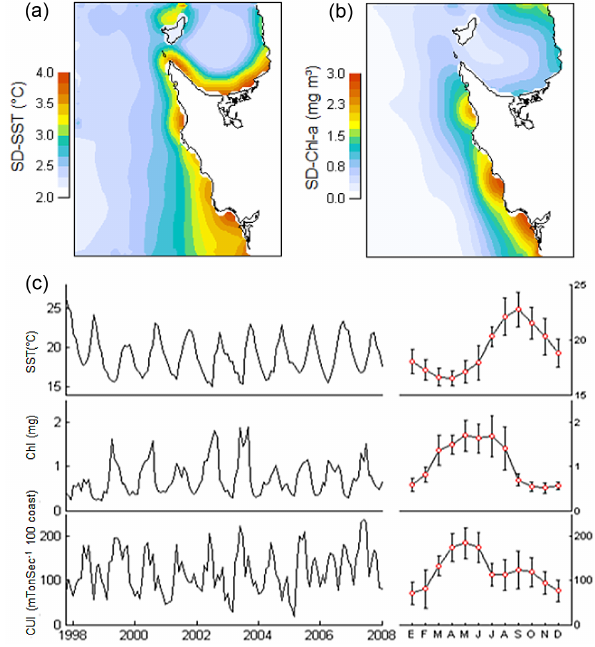
Fig. 2. Surface plots of standard deviation variability (time aver- aged) and monthly time series (spatial averaged) of the satellite- derived SST and chlorophyll a compared with the monthly CUI time series calculated from the Pacific Fisheries Environmental Group (PFEG) website (http://www.pfeg.noaa.gov/) for the Punta Eugenia region (27 ◦ N, 116 ◦ W). The curves on the right side cor- respond to the average seasonal cycle for each variable. Observed averages (red circles) and vertical bars indicate standard